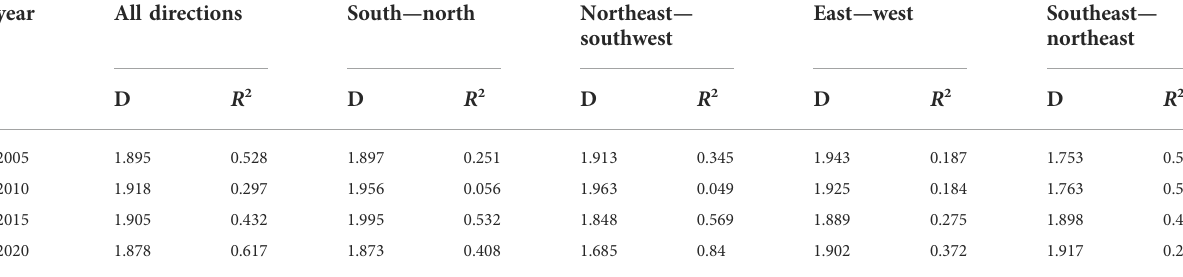
TABLE 2 Fractal of variogram on spatial pattern of county economy in Hubei province. year All directions South — north Northeast —